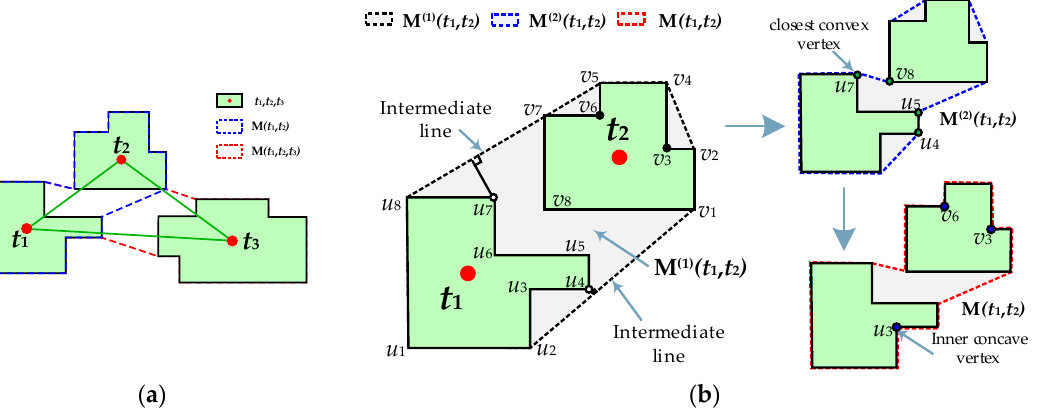
Figure 4. Aggregating neighboring candidate ‐ matching objects into pattern combinations: ( a ) aggregating two or more objects based on centroid distances; ( b ) aggregating two objects based on convex hull approximation.